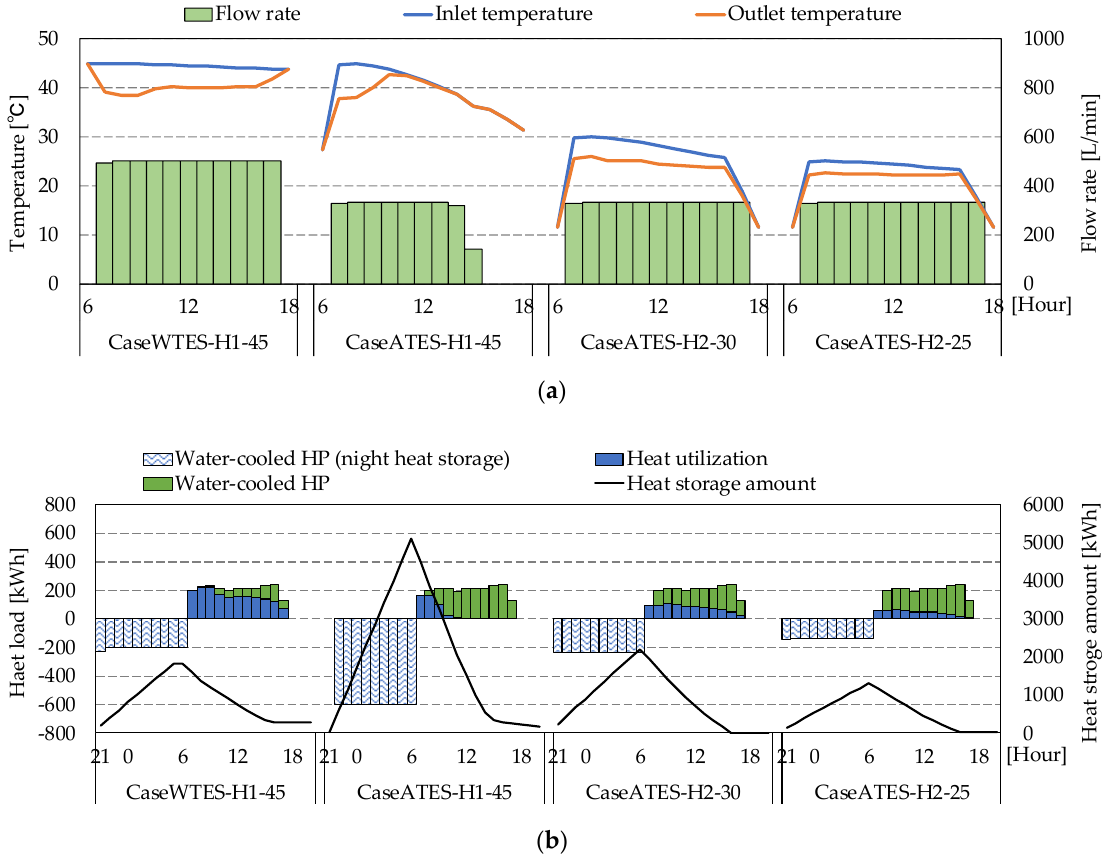
Figure 10. Operation analysis on 23 January in winter. ( a ) Flow rate and temperature of Heat Exchanger 2. ( b ) Operational transition of heat storage and heat utilization.